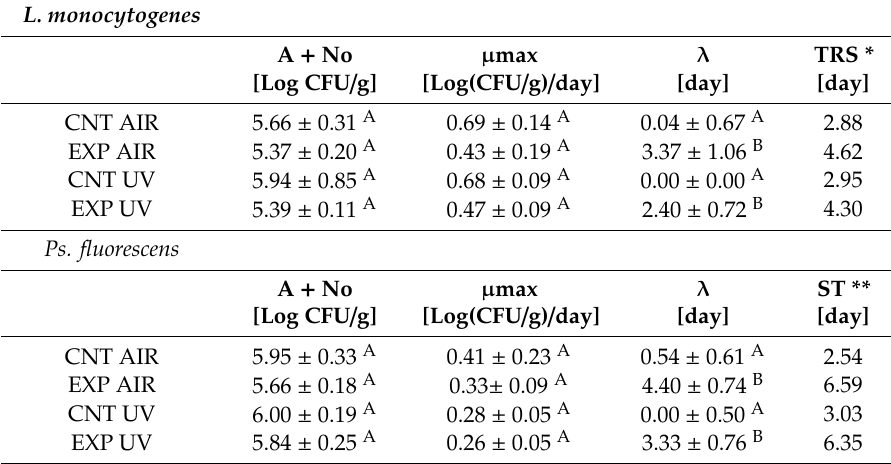
Table 4. Kinetic parameters calculated by fitting Gompertz equation to the experimental data by L. monocytogenes and Ps. fluorescens during their growth in soft cheeses with (EXP) or without (CNT) probiotic biofilms, packed in AIR o under vacuum (UV) and stored at 15 °C. (A + No) is the maximum bacterial load attained at the stationary phase, µ max is the maximal growth rate, λ is the lag time, TRS is the sanitary risk time, ST (stability time) is the maximum acceleration of microbial growth.